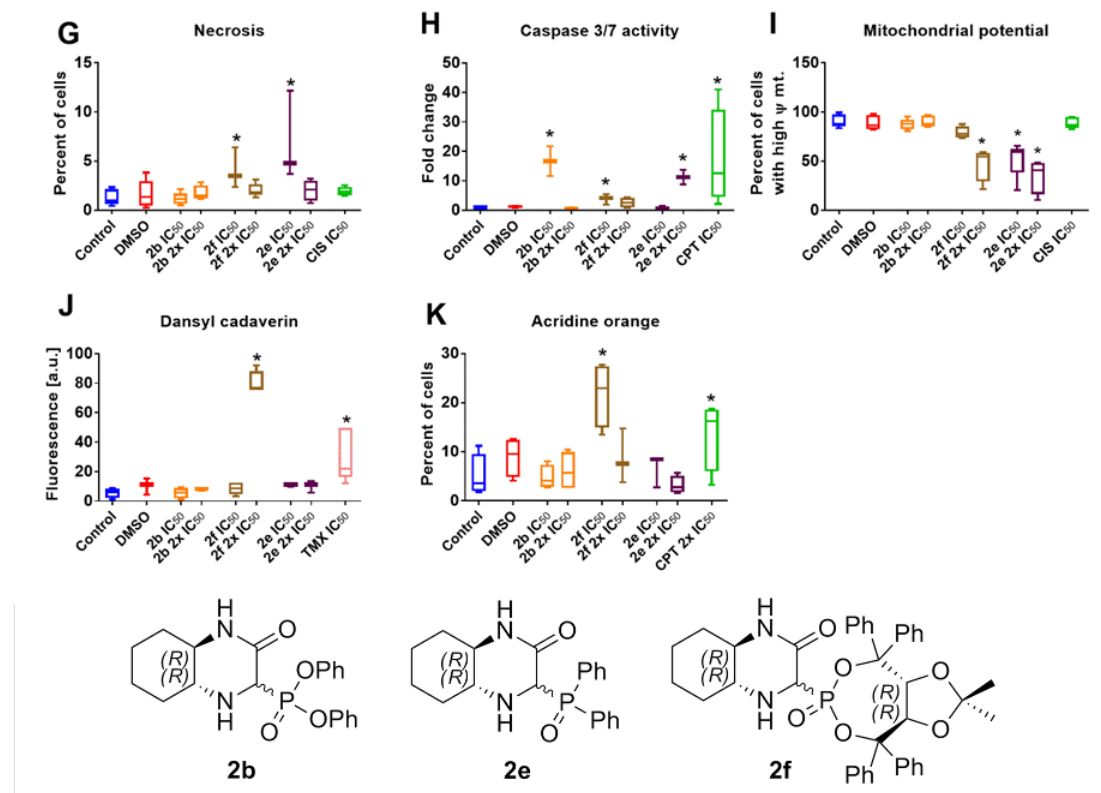
Figure 2. Biological activity of tested compounds on MV4-11 leukemia. ( A – D ) Cell cycle distribution including cells in ( A ) G0/G1, ( B ) S, ( C ) G2M and ( D ) death cells (sub G1). ( E – G ) Annexin V staining: